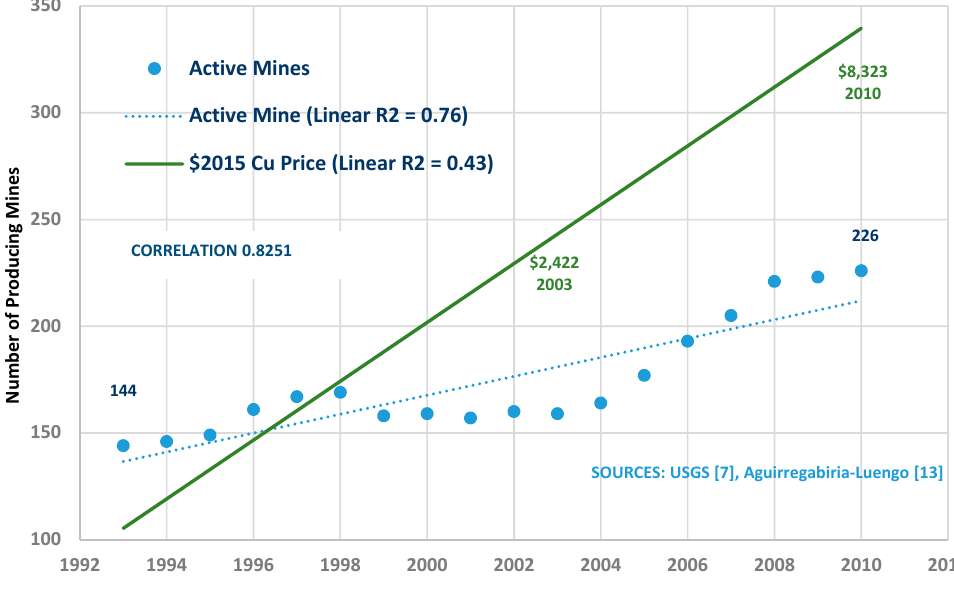
Figure 1. Number of producing mines & increasing copper price.